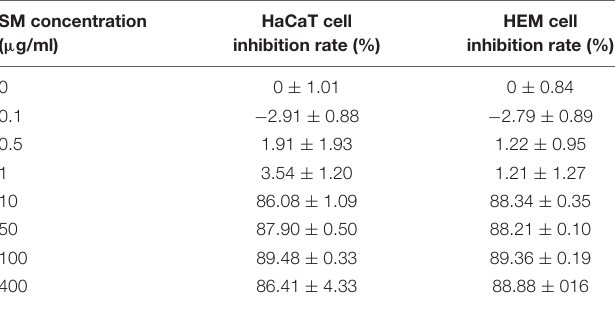
TABLE 1 | Cell viability of HaCaT cells and HEM cells at different concentrations of SM. SM concentration ( µ g/ml)